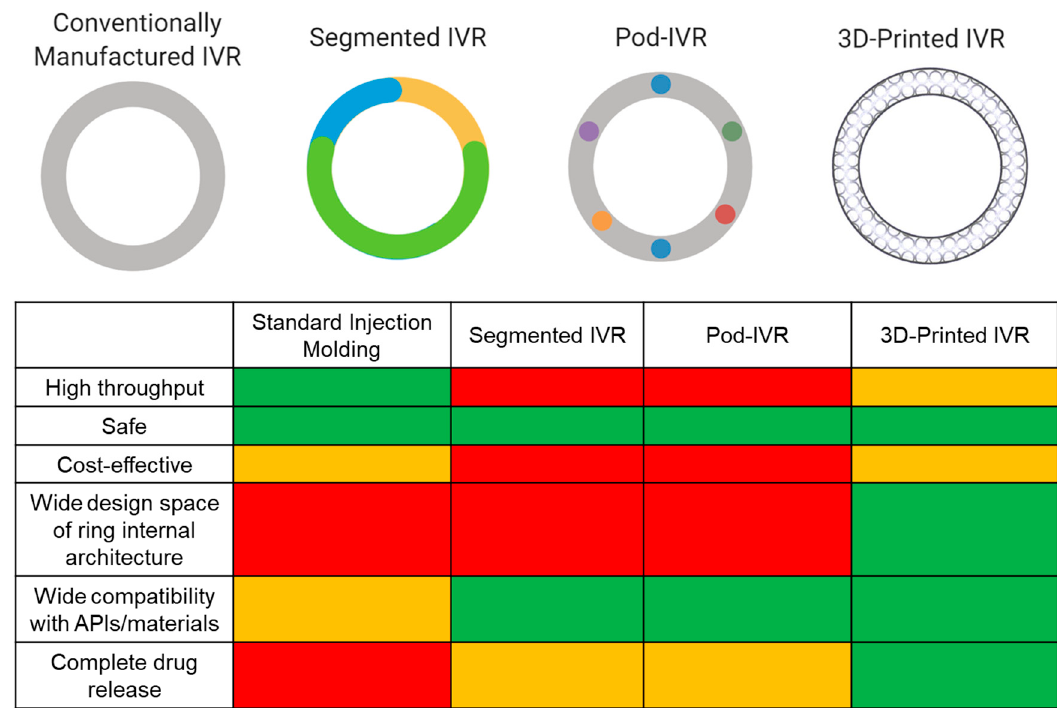
Figure 2. Comparison of IVR technologies. Conventionally manufactured (e.g., injection molding or hot-melt extrusion), segmented, pod, and 3D-printed IVRs. Different colors in the segmented and pod ring design allude to differences in material and APIs, respectively. A relative comparison of IVR characteristics and performance between fabrication methods is shown by the matrix. Green represents the best case, orange is the middle range, and red is the worst case. Figure created with BioRender.com, accessed on 19 July 2021.